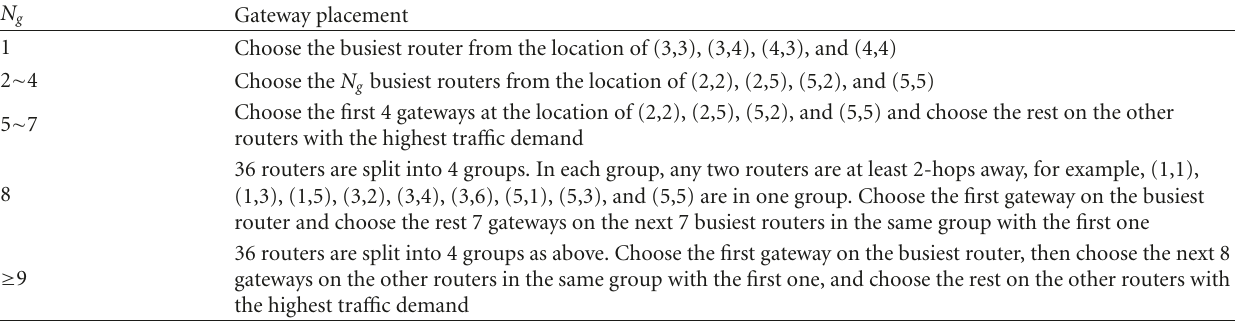
Table 2: An example for RGP on a 6-by-6 regular grid.